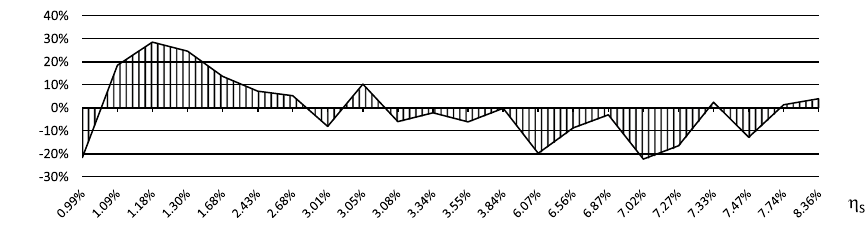
Fig. 7 Variations of ∆DCoF